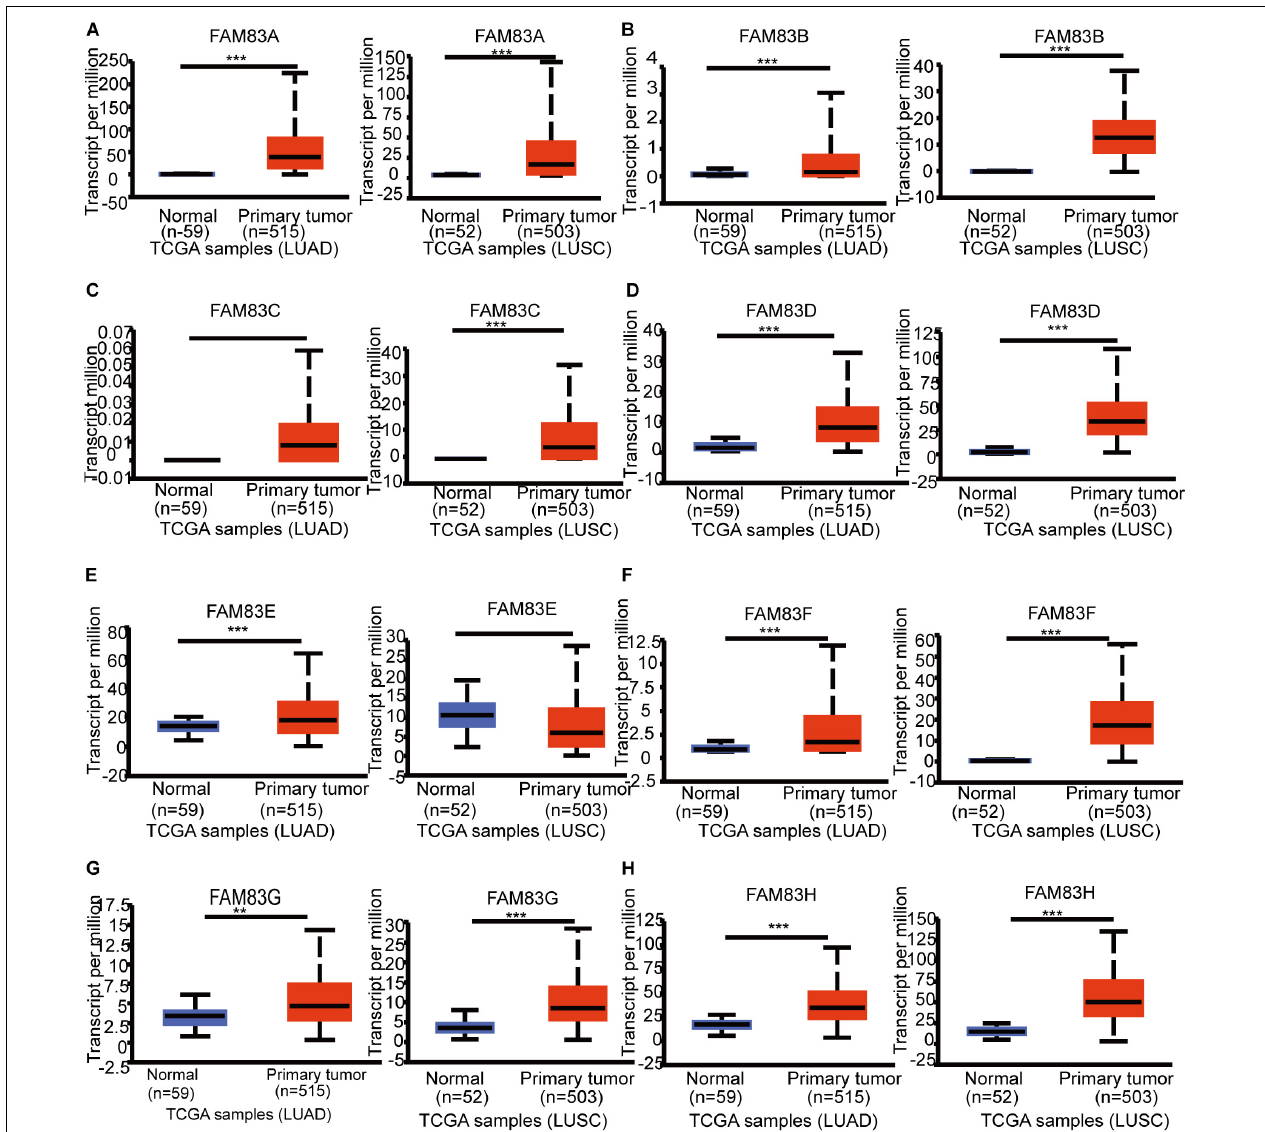
FIGURE 2 | The mRNA expression of diverse FAM83 family members in NSCLC tissues and adjacent lung tissues (UALCAN ). mRNA expressions of FAM83A/B/C/D/F/G/H were found to be over-expressed in LUAD and LUSC tissues compared to normal samples (A–D, F–H) . FAM83E was higher in LUAD tissues than in lung tissues, whereas and the expression level of FAM83E was lower in the LUSC tissues than in lung tissues (E) . *** p < 0.001, ** p <